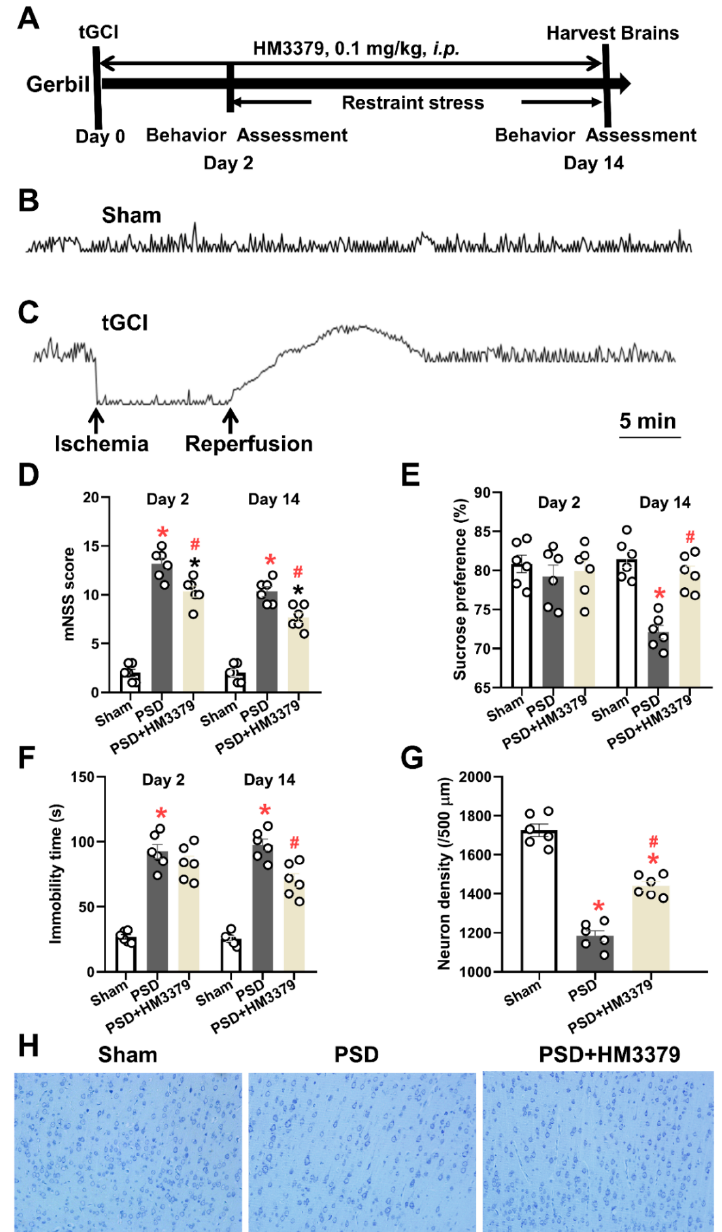
Figure 1. HM3379-affected depression-like behaviors and neurological injury in the PSD gerbils. ( A ) Schematic diagram of the experimental protocol. The gerbils were subjected to tGCI, and restraint stress was initiated on day 2 after tGCI surgery for 12 consecutive days to make a PSD model. HM3379 (0.1 mg/kg, i.p. ) was administrated for 14 days. The neurobehavioral outcomes and depressive-like behavior were assessed on the 2nd and 14th days. Typical recordings show rCBF in gerbils with sham operation ( B ) and tGCI-reperfusion surgery ( C ). ( D ) HM3379 post-conditioning showed a significant decrease in mNSS at day 2 and day 14 post-injury. HM3379 improved depression-like behavior in sucrose preference test ( E ) and forced swim test ( F ) in PSD gerbils. ( G ) Neuronal density in the cortex regions. Neuronal loss in PSD gerbil model was significantly ameliorated by HM3379. ( H ) Representative photomicrographs of Nissl-stained brain sections. Data are presented as mean ± SEM. * indicates p < 0.05 vs. Sham, # indicates p < 0.05 vs. PSD. N = 6 per group. Scale bars = 100 µ m. PSD, post-stroke depression. tGCI, transient global cerebral ischemia. rCBF, regional cerebral blood flow. mNSS, modified neurological severity